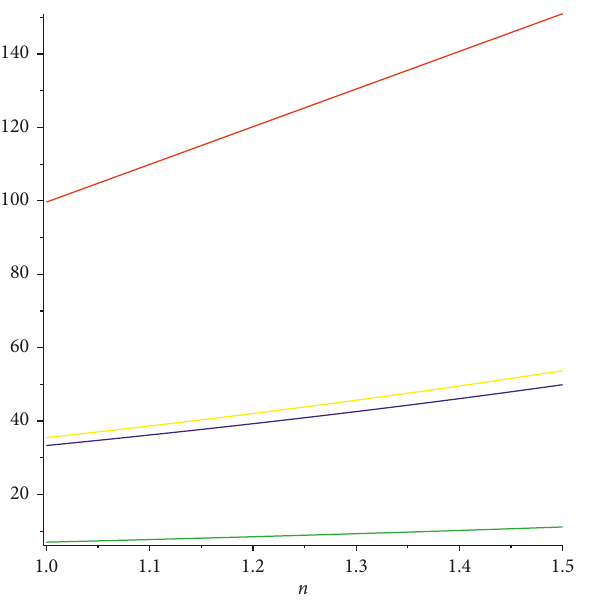
Figure 16: IRLU of D